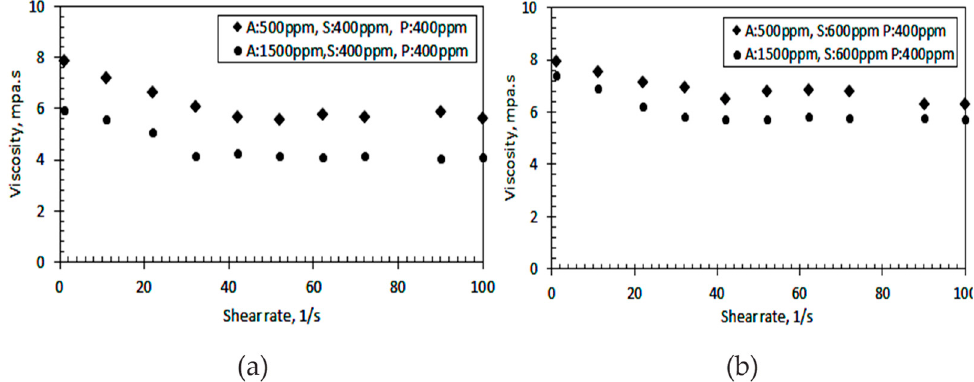
Figure 11. Viscosity variation in the residual emulsion with a low and high composition of alkali in the presence of constant polymer at a temperature of 60 °C: ( a ) S = 400 ppm and ( b ) S = 600 ppm. Table 9. Viscosity of the emulsion at alkali, 500 ppm, and 1500 ppm, surfactant 400 ppm, polymer 600 ppm. Meas. Pts.